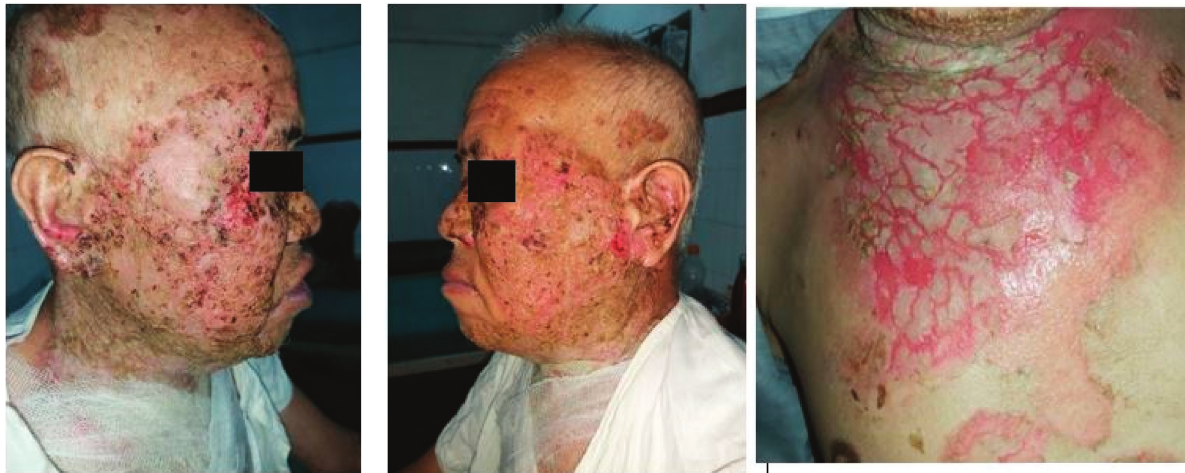
Figure 3: Day 20 of admission: improvement of erosions but appearance of haemorrhagic crusts.